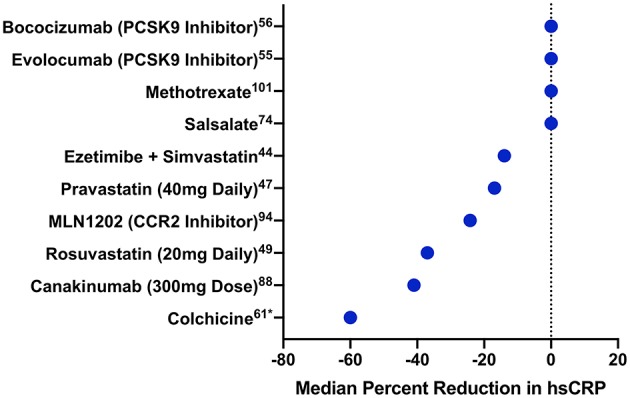
Median percentage change in hsCRP with different cardiovascular drugs. Median percentage change in hsCRP is displayed for several drugs from trials of patients either with established cardiovascular disease or at high risk for cardiovascular events. Drugs are ordered by their impact on hsCRP. PCSK9 indicates proprotein convertase subtilisin-kexin type 9; CCR2, CC-chemokine ligand 2 receptor. *Mean, rather than median, percentage change.